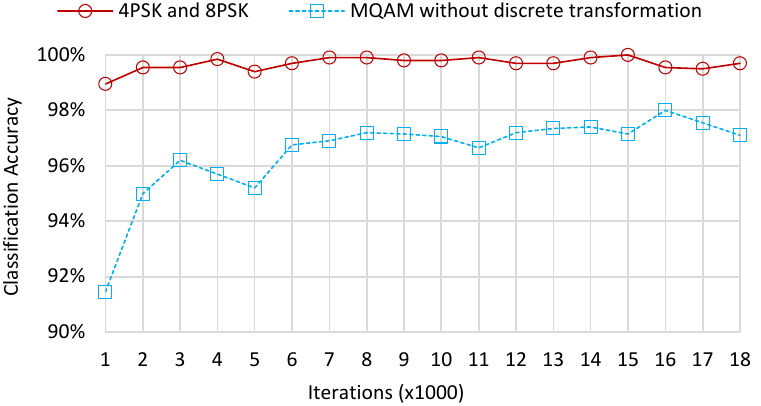
Figure 6. Classification accuracy of the leaf layers for MPSK and MQAM without discrete